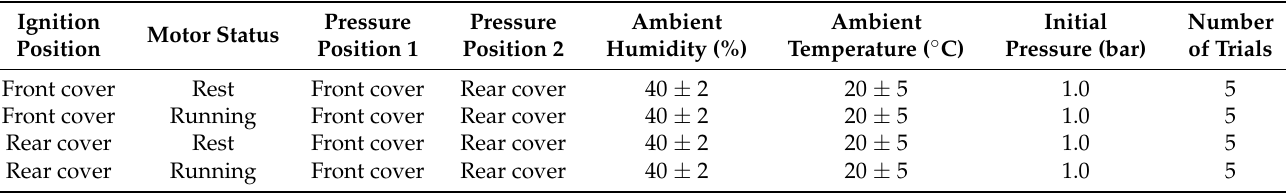
Figure 6. Schematic layout of Sample 2. Table 2. Experimental condition for Sample 2.